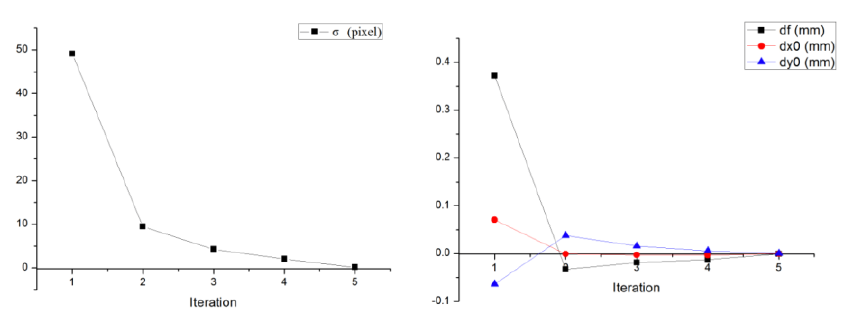
Figure 2. Changes of σ and the corrections of interior orientation parameters of Trial A .